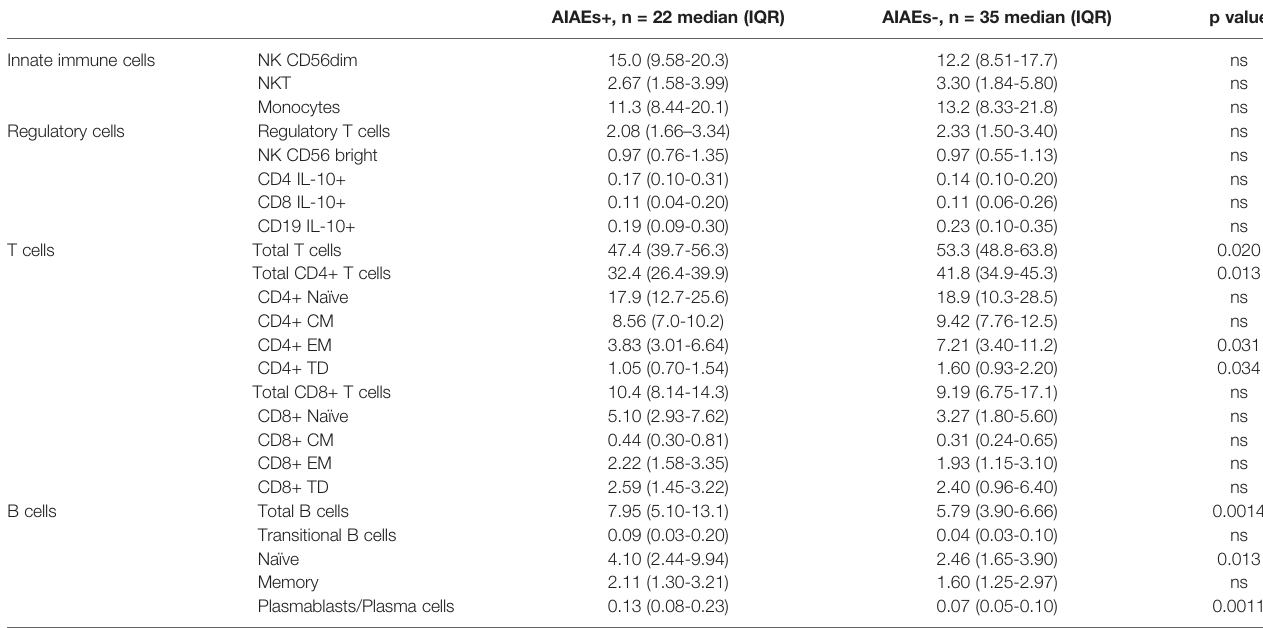
TABLE 3 | Percentages of peripheral blood mononuclear cells at